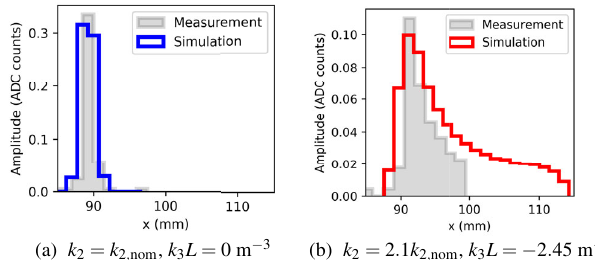
FIG. 19. Horizontal beam profile at BSGH.218 inside MSE.